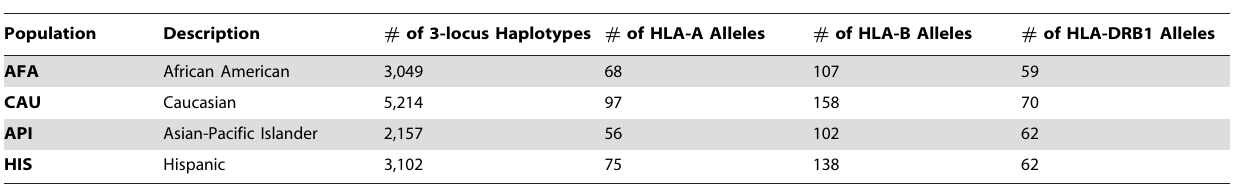
Table 2. HLA haplotype frequency data used in this study.